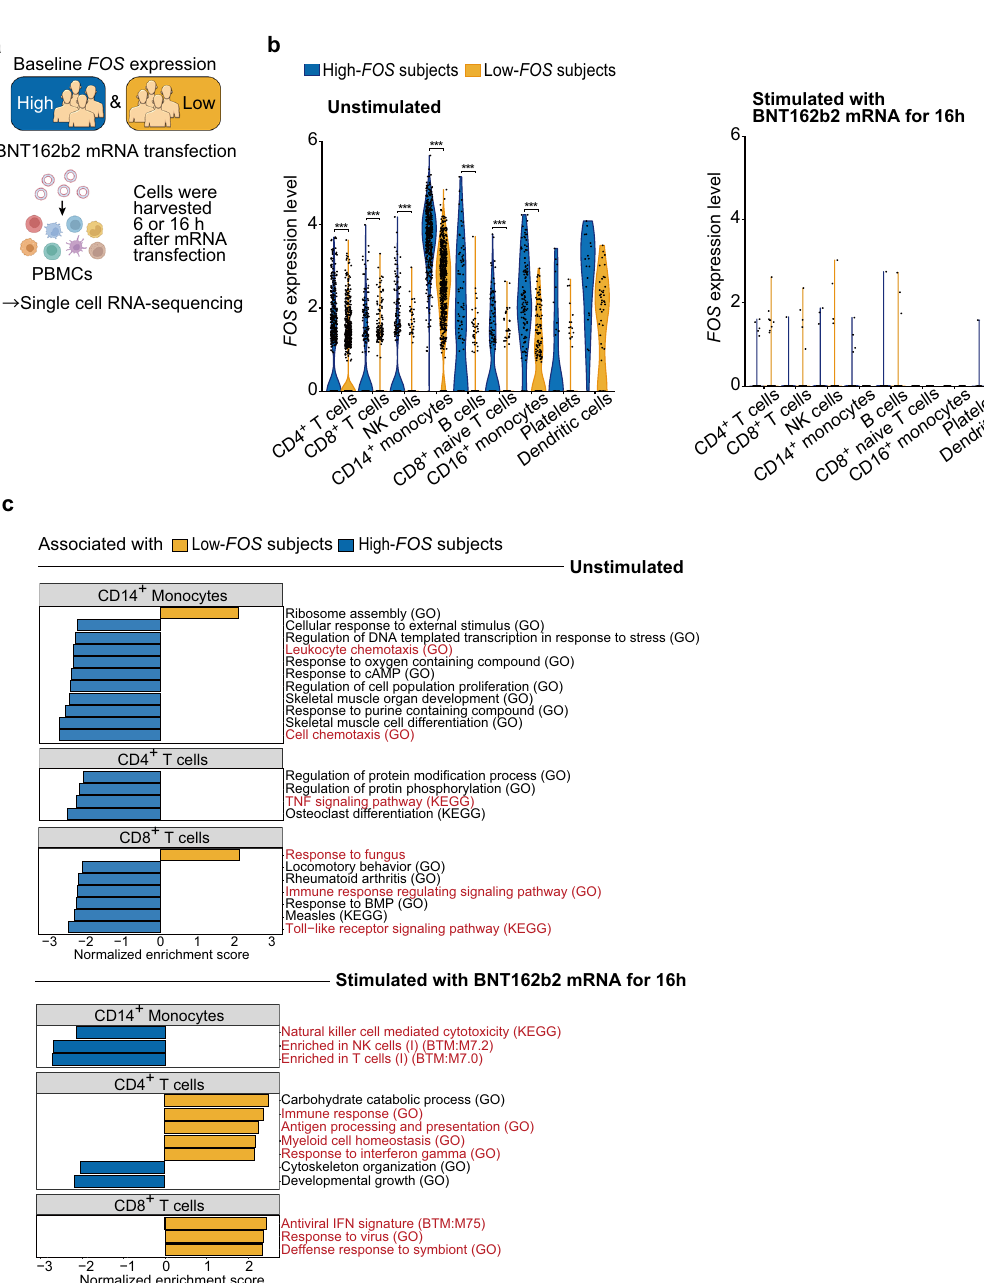
Fig. 5 Association between baseline FOS expression and ex vivo responses of PBMC to BNT162b2 mRNA. PBMCs isolated from subjects who exhibited high- or low- FOS expression in the bulk RNA-seq analysis (high- and low- FOS subjects, n = 4 each) were either unstimulated or stimulated with BNT162b2 mRNA for 6 or 16 h, followed by scRNA-seq analysis. a Schematic illustrating the experimental design of scRNA-seq of high- and low- FOS subjects. b Violin plots showing expression of FOS in PBMCs unstimulated (left panel) and stimulated with BNT162b2 mRNA for 16 h (right panel). FOS expression levels in each immune cell population were compared between high- and low- FOS subjects ( n = 4 each). P values were calculated with Wilcoxon rank-sum tests with Benjamini – Hochberg FDR correction (*** P < 0.001). c GSEA on a ranked gene list based on the change in expression in CD14 + monocytes , CD4 + T cells, and CD8 + T cells unstimulated or stimulated with BNT162b2 mRNA for 16 h between high- and low-FOS subjects. Immune-related pathways are shown in